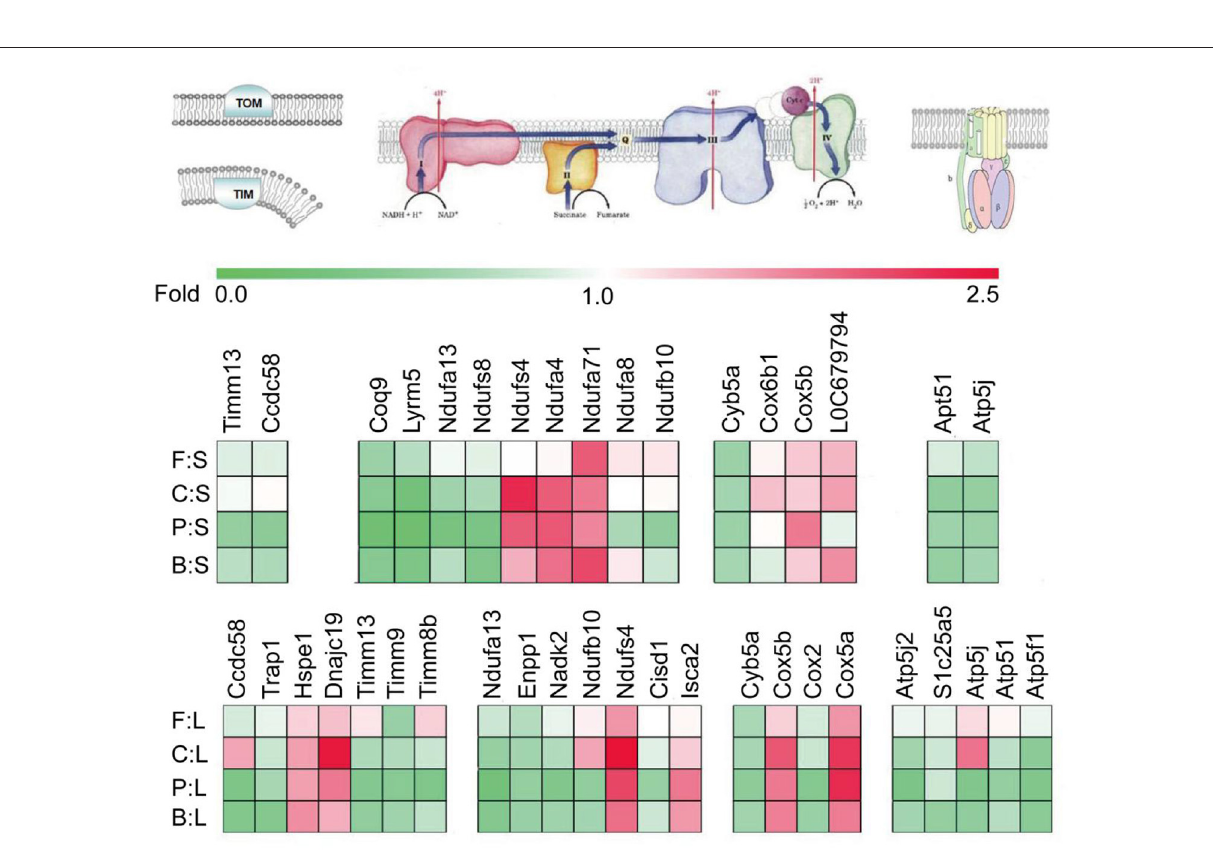
Frontiers in Nutrition |